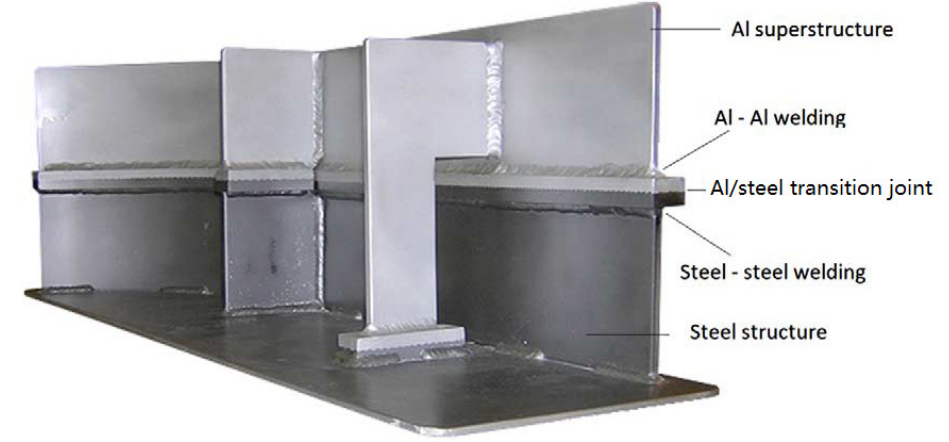
Figure 23 . Example of an Al/Steel EW joint in shipbuilding. Figure 23. Example of an Al/Steel EW joint in